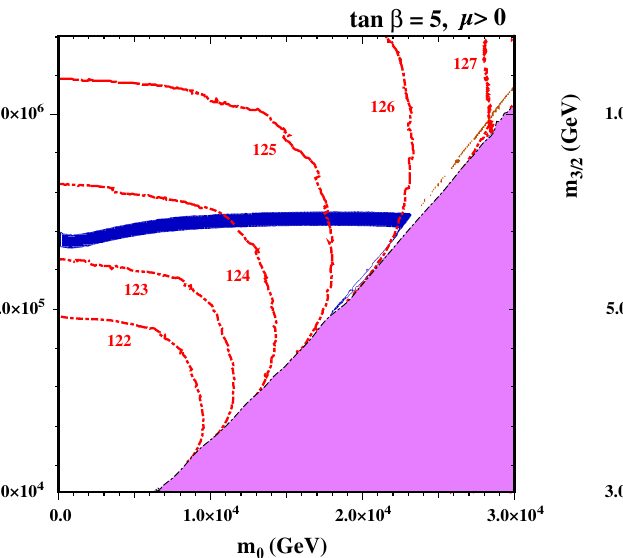
Fig. 2 The ( m 0 , m 3 / 2 ) plane for tan β = 5 without ( left panel ) and with ( right panel ) the Sommerfeld enhancement, as calculated using SSARD . There are no consistent solutions of the electroweak vacuum conditions in the pink shaded triangular regions at lower right . The